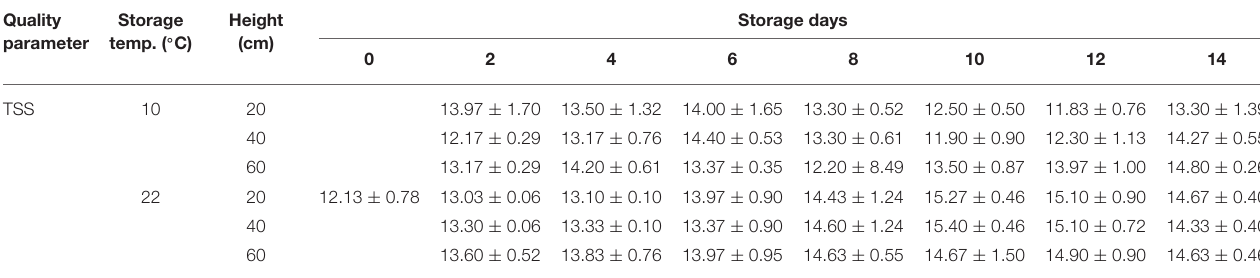
TABLE 4 | Total soluble solids (TSS) value ( ◦ Brix) of pears impacted with three drop heights levels at two storage conditions during 14 days of storage. Quality Storage parameter temp. ( ◦